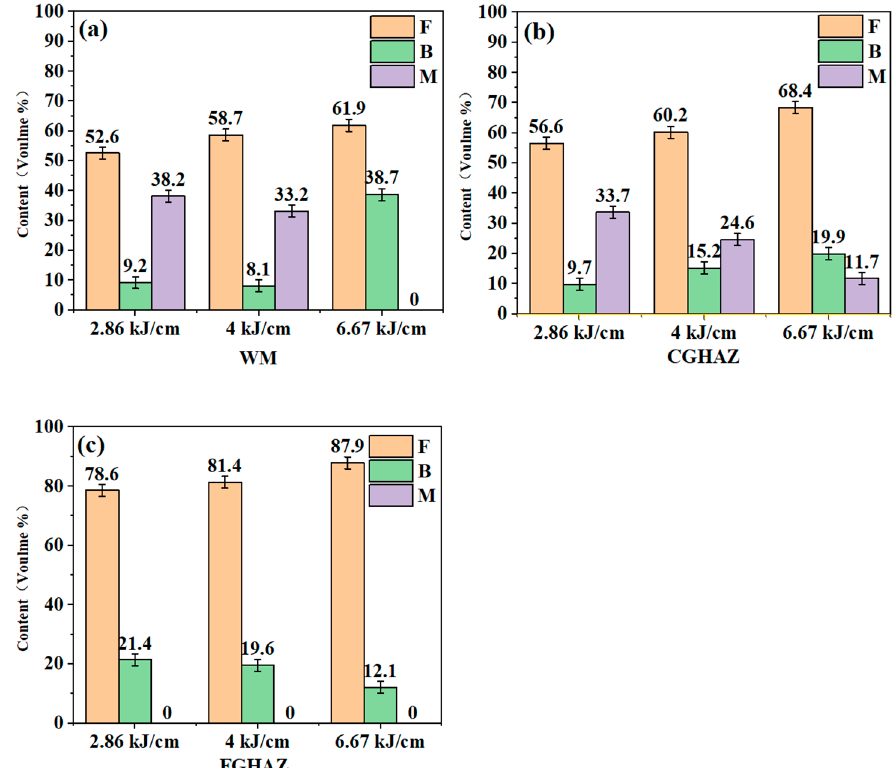
Figure 7. Histograms of microstructure proportion of welded joints with different heat inputs: ( a ) welded metal; ( b ) CGHAZ and ( c ) FGHAZ.